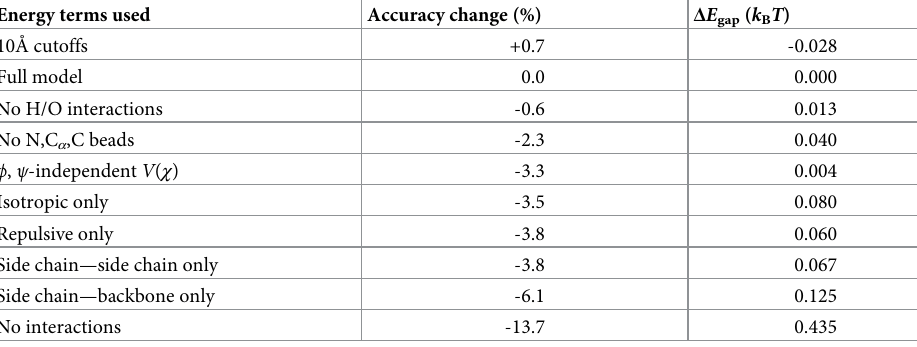
Table 1. Accuracy of predicting χ 1 for the SCWRL4 data set. Energy terms used